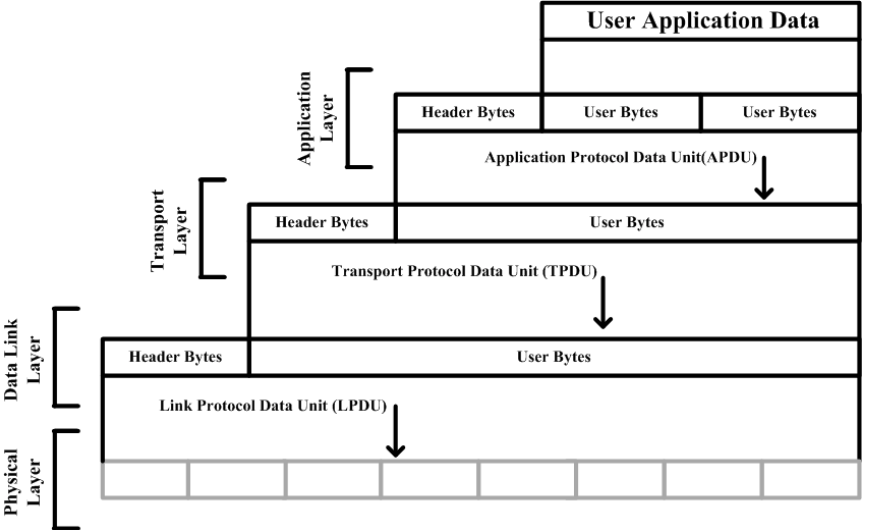
Figure 2. DNP3 protocol model.